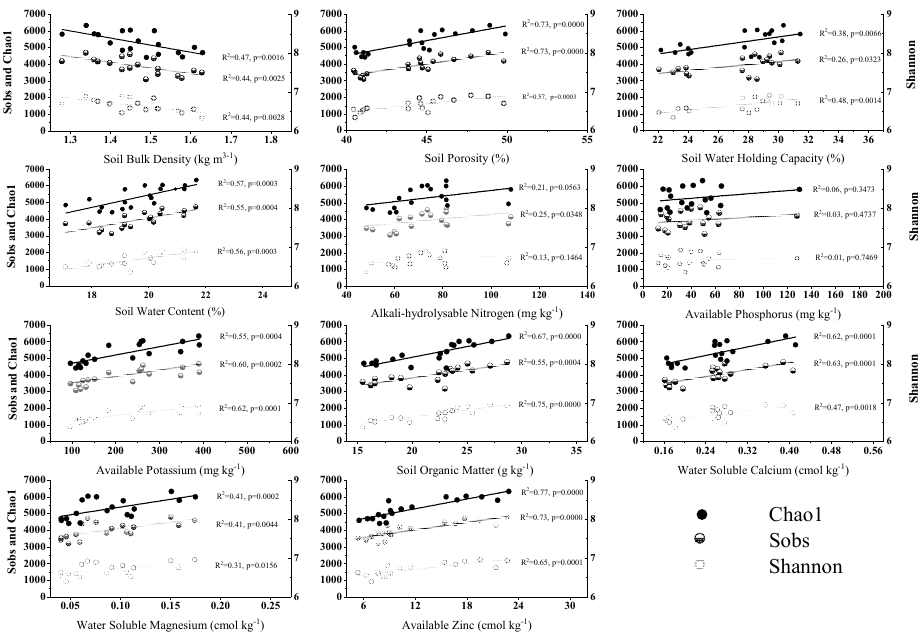
Figure 3. Correlation analysis between soil characteristics and alpha diversity. Left Y axis indicates Sobs and Chao1 values, while right Y axis indicates Shannon value.